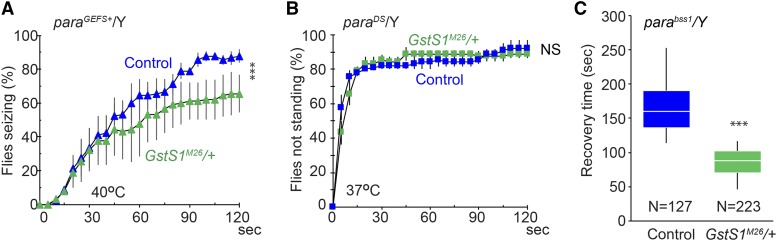
Phenotypes of other neurological mutants are suppressed by GstS1M26. (A) Frequencies of heat-induced seizure at 40°C in paraGEFS+ plus GstS1M26 males (paraGEFS+/Y; GstS1M26/+) or paraGEFS+ males (paraGEFS+/Y; +/+). (B) Frequencies of paraDS males that did not stand at 37°C. For (A) and (B), averages of 3 experiments and SEM are shown. In each experiment, 30 flies were examined. (C) Recovery time required for parabss1 plus GstS1M26 males (parabss1/Y; GstS1M26/+) and parabss1 males (parabss1/Y; +/+) to recover from paralysis induced by mechanical shock. Data are presented as box plots. Total numbers of flies observed were 127 and 223 flies for parabss1/Y; +/+ and parabss1/Y; GstS1M26/+, respectively. Data analysis involved two-way repeated measures ANOVA and Holm-Sidak multiple comparisons (A and B) and the Mann-Whitney U-test (C). ***P < 0.001; *P < 0.05; NS, not significant (P > 0.05).